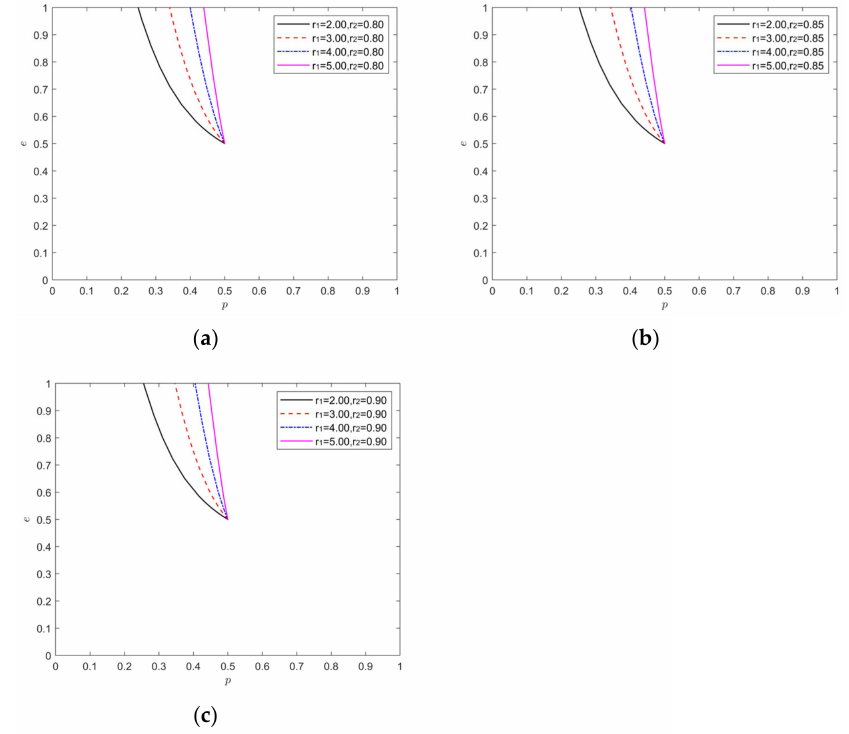
Figure 5. The development of the game’s strategy in a (pessimistic, optimistic) condition. ( a – c ) represent the results of different parameter